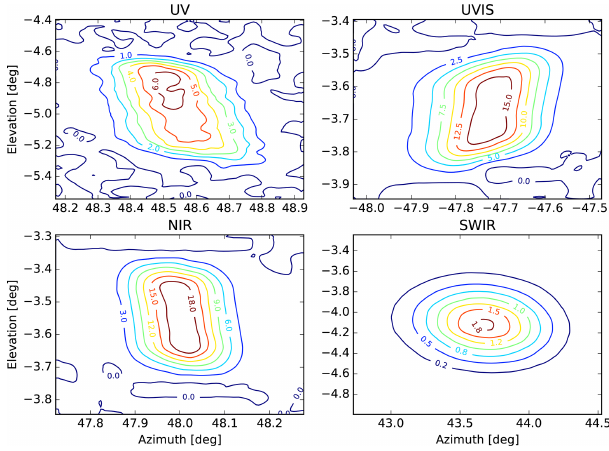
Figure 31. Same as Fig. 30, but now for a pixel on the corner of each detector.